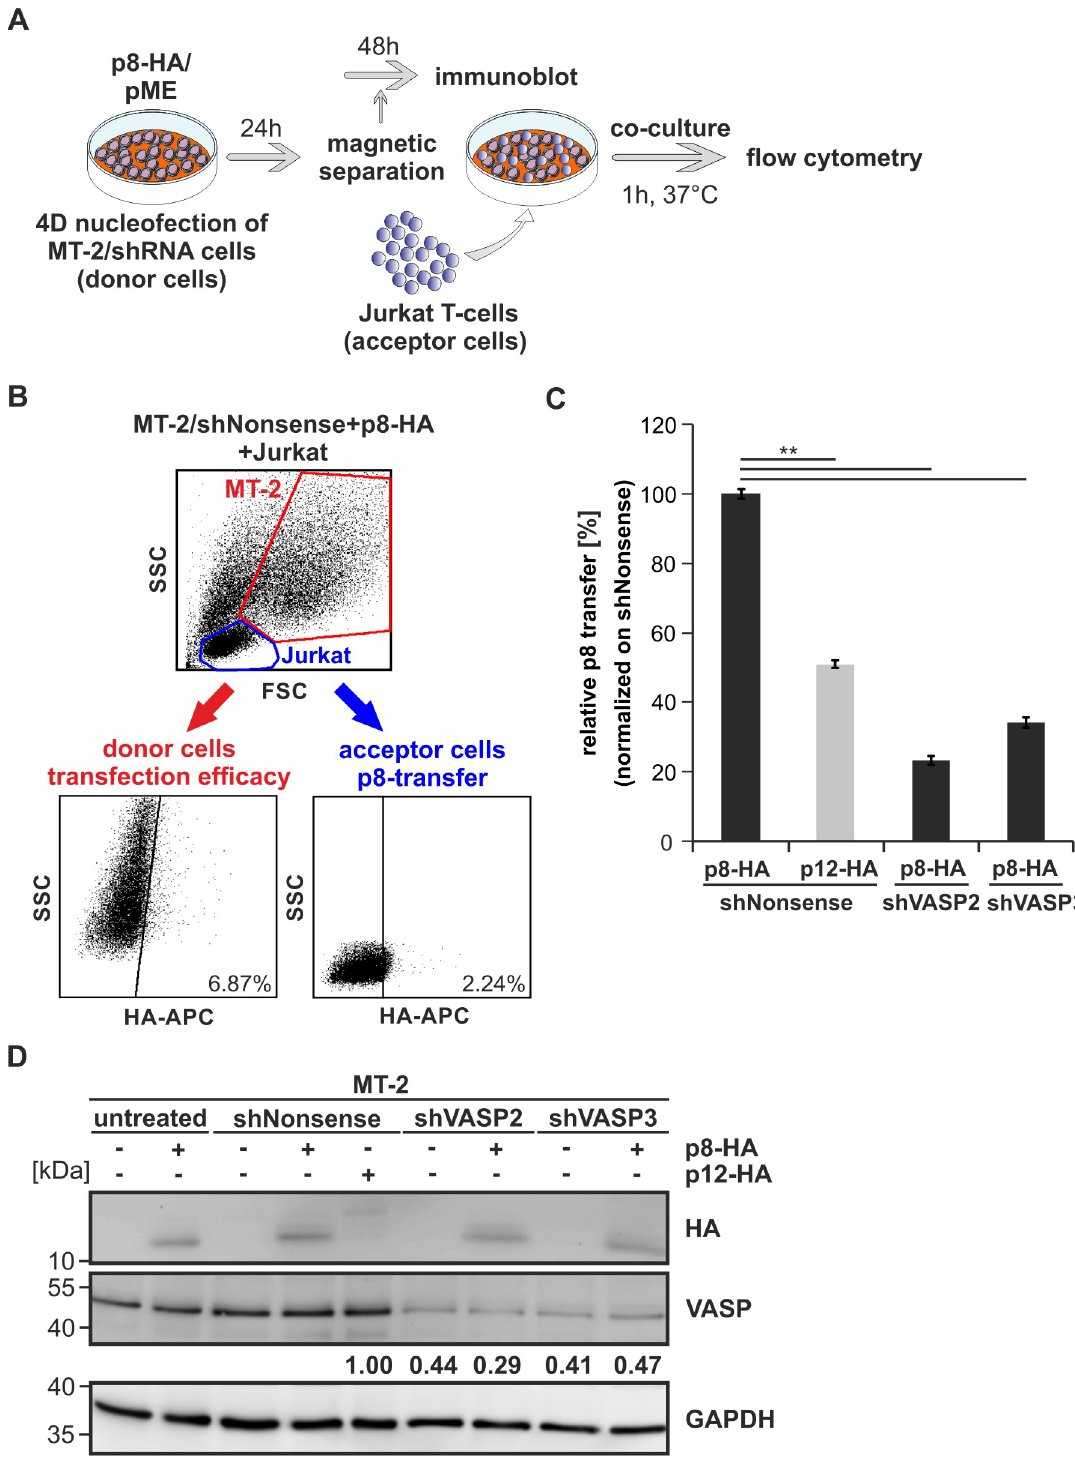
Fig 9. Repression of VASP impairs p8-transfer between chronically-infected MT-2 cells and uninfected T-cells. (A) Experimental setup. (B-D) Stably transduced MT-2 cells (shNonsense, shVASP2, shVASP3) were nucleofected with p8-HA expression plasmids or a control plasmid together with pMACS-LNGFR. At 24 h post transfection, transfected MT-2 cells were enriched by magnetic separation using anti-LNGFR microbeads. Separated MT-2 cells were either (B-C) co-cultured with target Jurkat T-cells (ratio 1:1) for 1 h at 37˚C and subjected to flow cytometry or (D) MT-2 cells were cultured for another 48 h and lysed for western blot analysis. (B) Flow